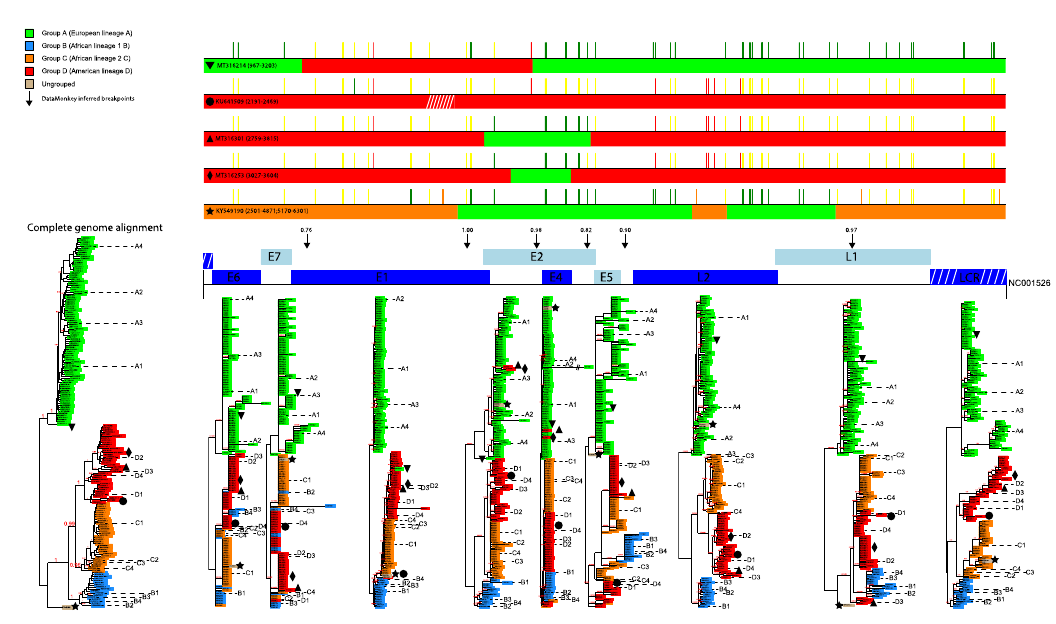
Figure 2. Phylogenetic analyses and identification of potential recombinant sequences. Complete genome alignment was performed with mafft, whereas individual gene alignments were performed with MUSCLE. PhyML trees were generated with GTR + I + G model. Lineage A is coloured light green, lineage B (Af–1) is coloured blue, lineage C (Af–2) is coloured orange, and lineage D is coloured red. The sequence KY549190 appears to be between the two lineages and is assumed “Ungrouped” in the phylogenomic tree. Above the phylogenetic trees, each recombinant sequence is depicted with coloured blocks corresponding to the major and minor parent lineages. Vertical lines above each recombinant sequence represent lineage-specific SNPs. Green lines correspond to A-lineage SNPs, yellow to BCD-clade SNPs, orange to C-lineage SNPs and red to D-lineage SNPs. Recombination crossover sites as detected by GARD are displayed with downward arrows above the genome architecture diagram.